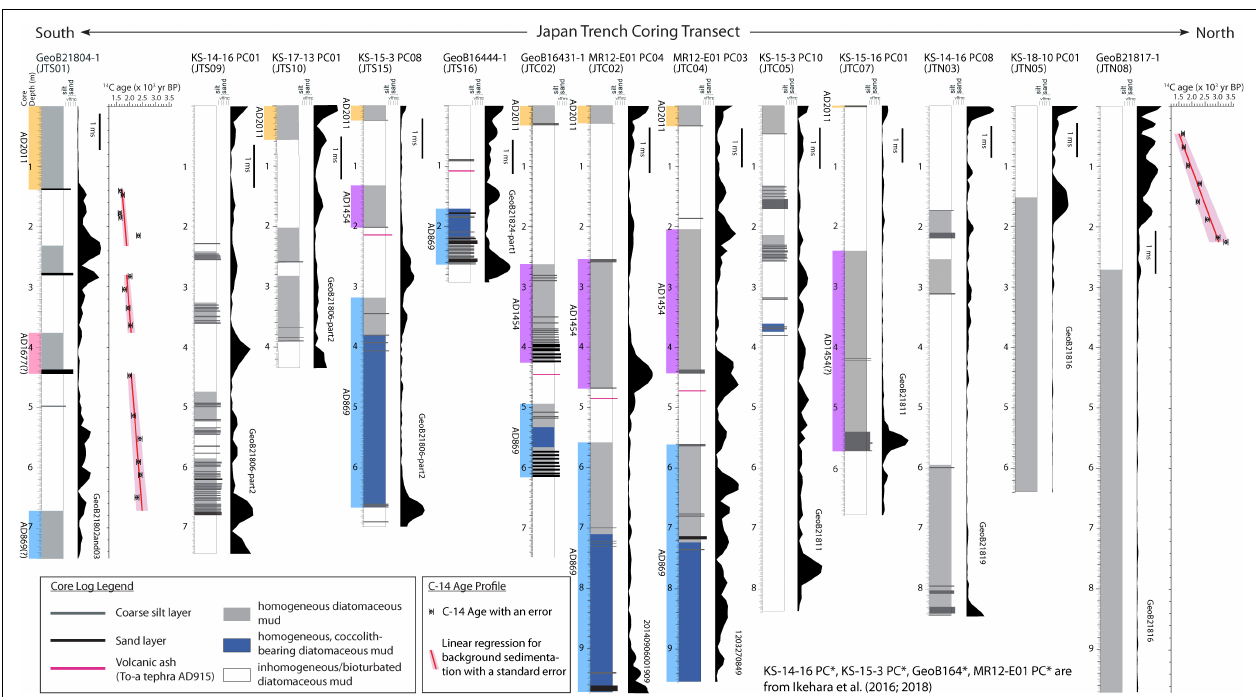
FIGURE 6 | Sediment cores taken at the trench-fill basins of Japan Trench identified in this study, wiggles of SBP data at the core locations, and 14C age profile. The cores GeoB21804, KS-17-13 PC01, KS-15-16 PC01, KS-18-10 PC01, and GeoB21817 are from this study, while the other cores are from previous studies (Ikehara et al., 2016, 2018; Bao et al., 2018). See Figures 2–4 and Supplementary Figure S1 for the locations of cores.